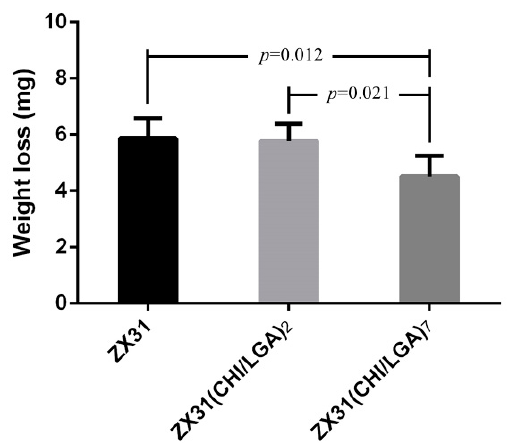
Figure 9. Mg clips taken from the rabbits five weeks after surgery: ( a ) ZX31 clips; ( b ) ZX31(CHI/LGA) 2 clips; ( c ) ZX31(CHI/LGA) 7 clips.